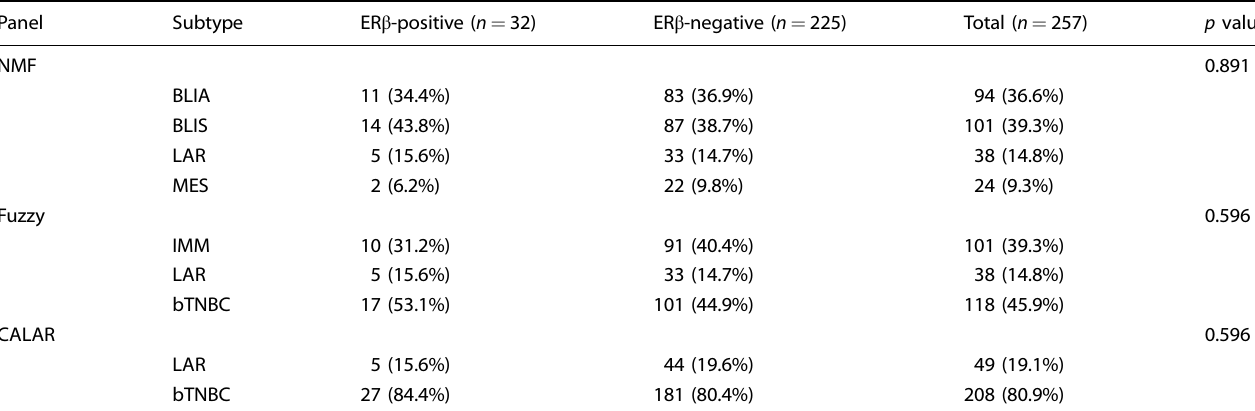
Table 2. Distribution of ER β + and ER β − TN tumors across TNBC subtypes. Panel